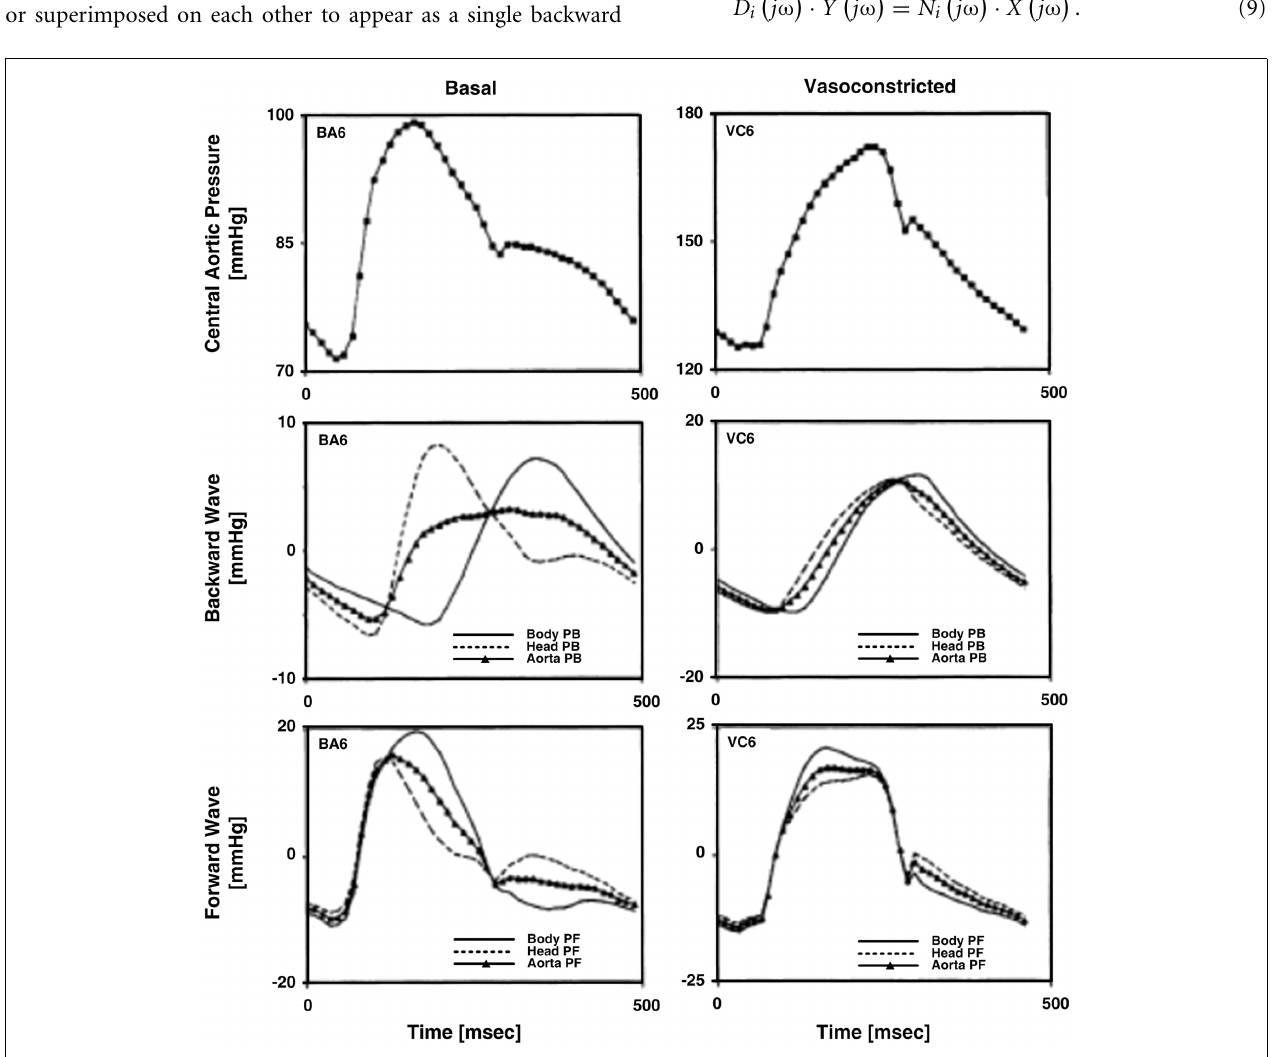
FIGURE 4 | Measured central aortic pressure waveforms and forward and backward pressure waves in the central aorta (PF and PB) calculated from central aortic pressure and flow and descending aortic flow waveforms. Adapted from Burattini et al. (1991).